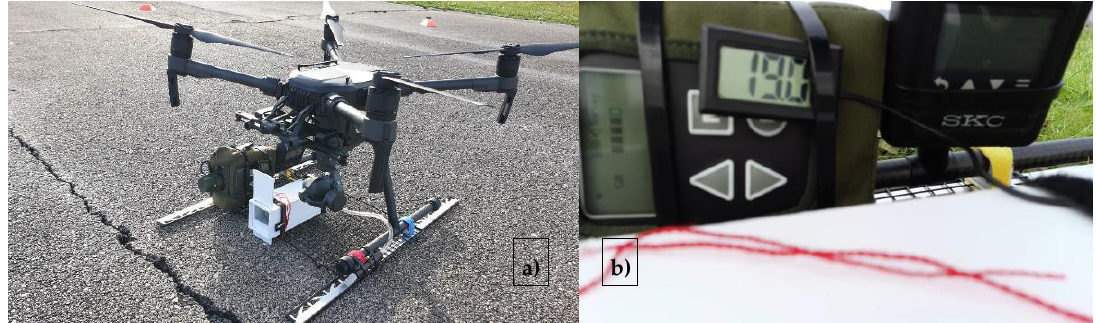
Figure 7. ( a ) The field test campaign arrangement; ( b ) the screen view of LCD3.3 detector on the alarm.